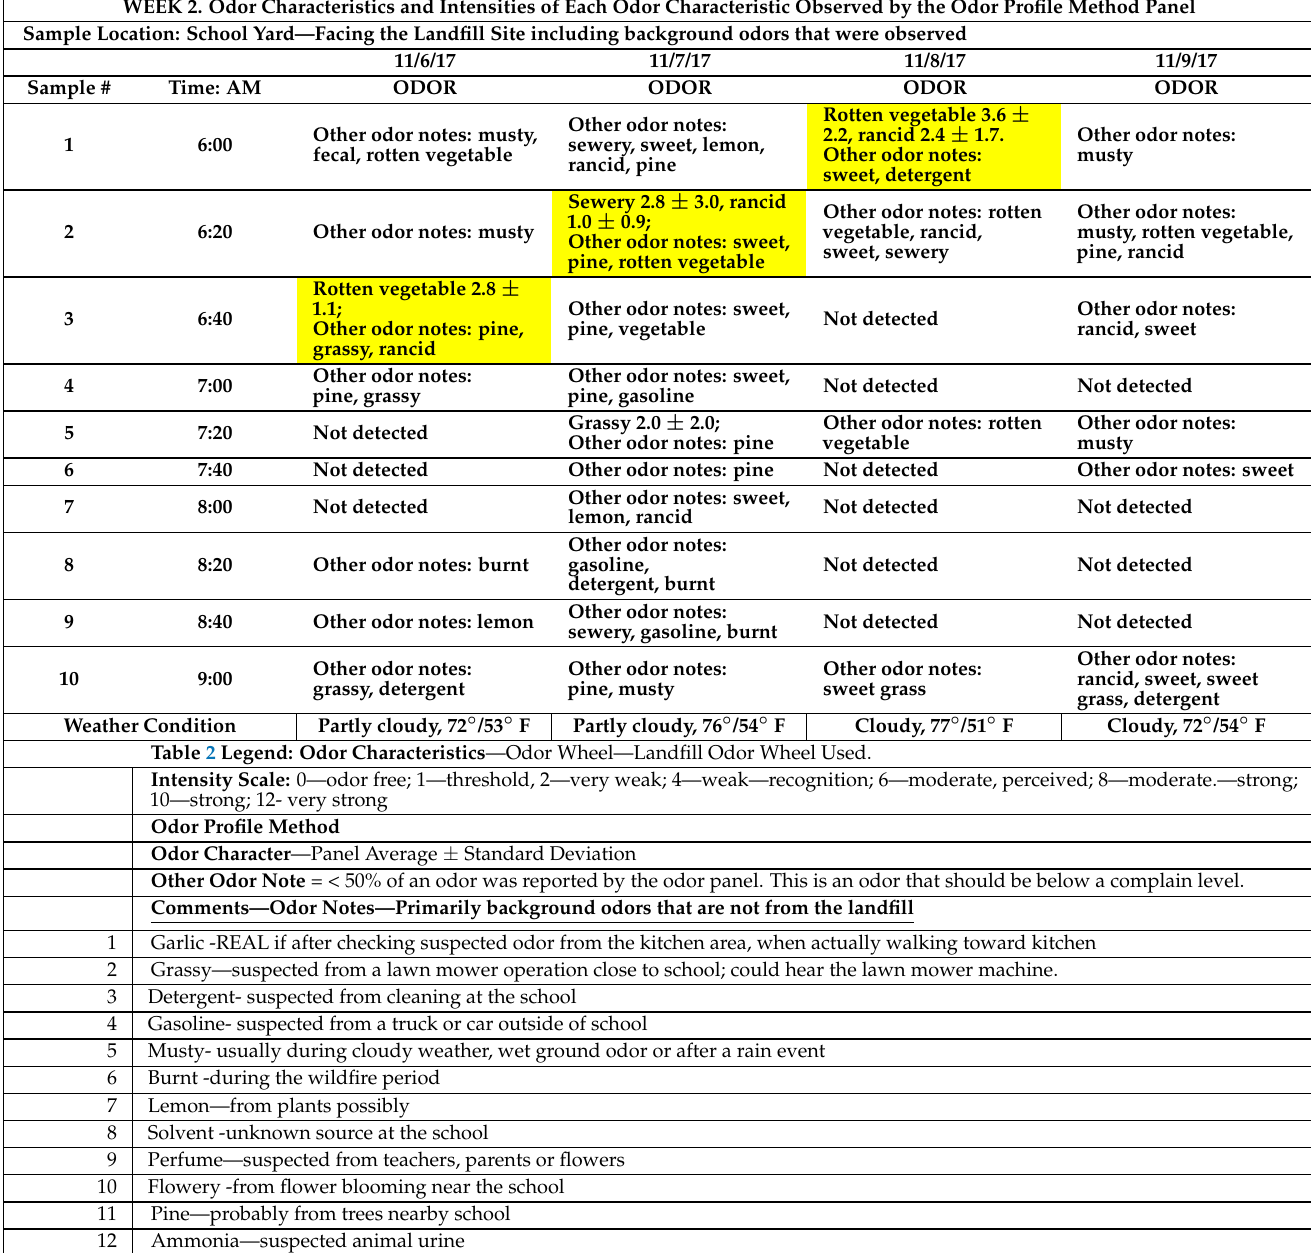
Table 2. Exemplary Weekly Data Sheet for Week 2.